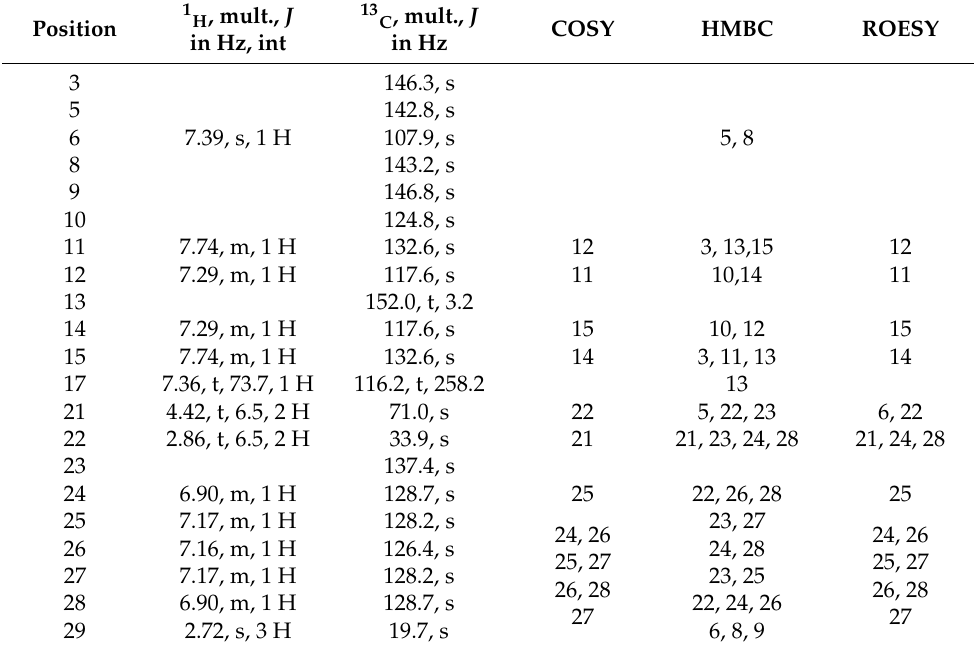
Table 2. NMR data for compound 13 in DMSO- d 6 a .